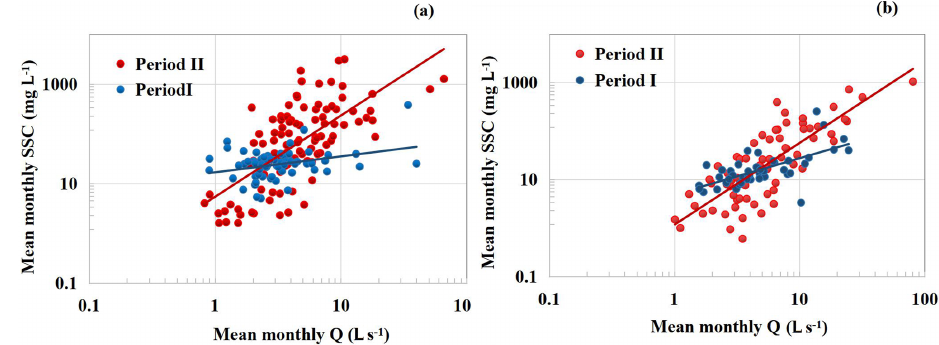
Figure 5. Sediment rating curves for (a) the growing seasons and (b) the dormant seasons during the two time periods. Each point represents a monthly mean observation.